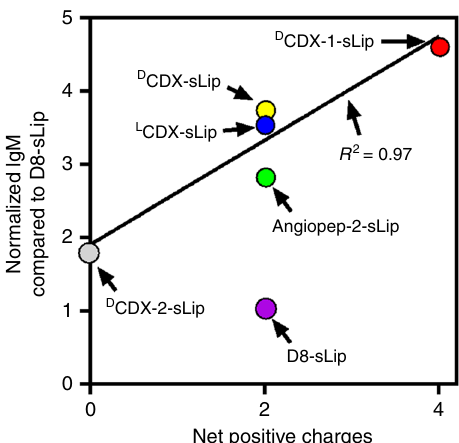
Fig. 9 Relationship between net positive charge of peptide ligands and absorbed natural IgM. n = 3, data are means. Linear regression was performed with L CDX-sLip, D CDX-sLip, D CDX-1-sLip, and D CDX-2-sLip